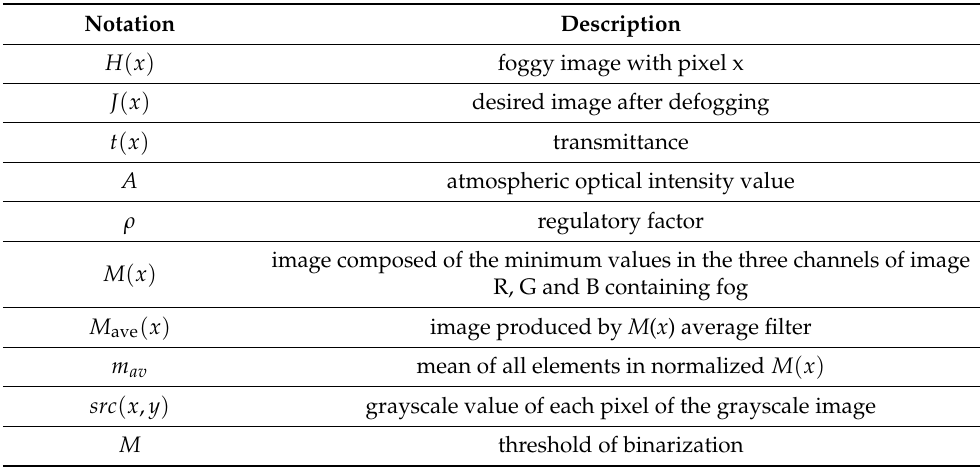
Table 1. Description of notations.